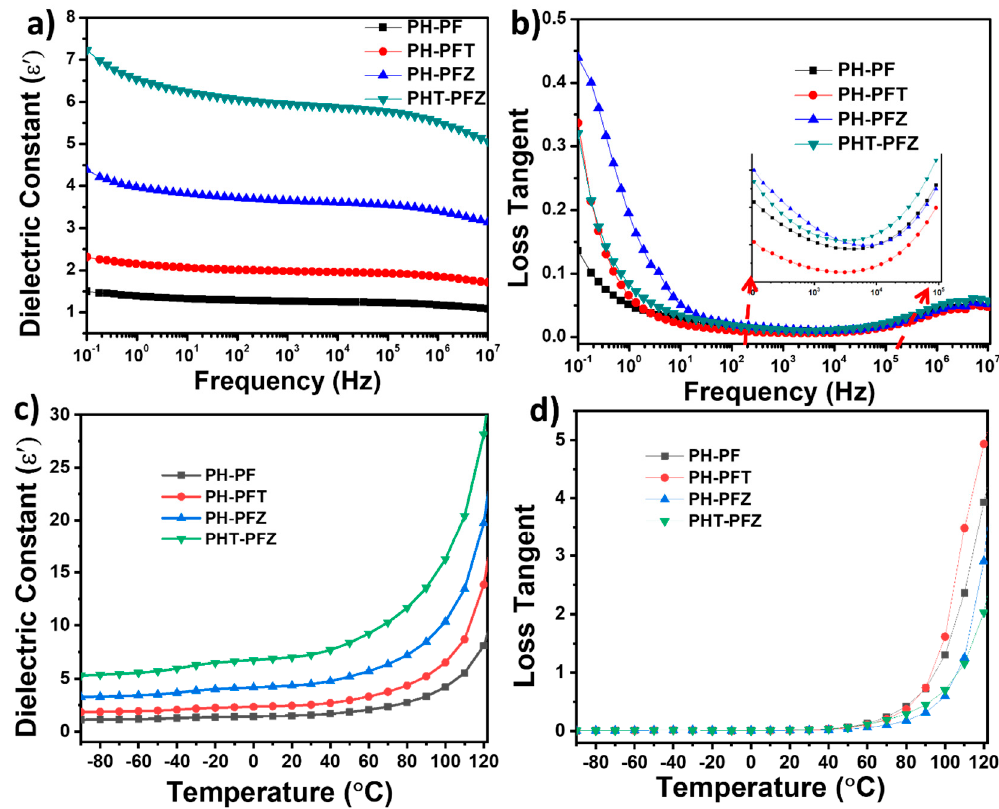
Figure 8. Dielectric properties of the coaxial electrospun fibers ( a ) dielectric constant and ( b ) loss tangent with frequency at room temperature; ( c ) dielectric constant and ( d ) loss tangent variation with temperature at 10 Hz.